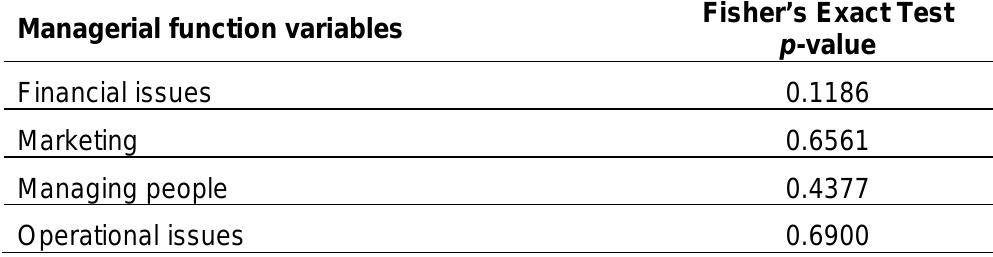
Table 1: Significant Differences Relating to Managerial Functions